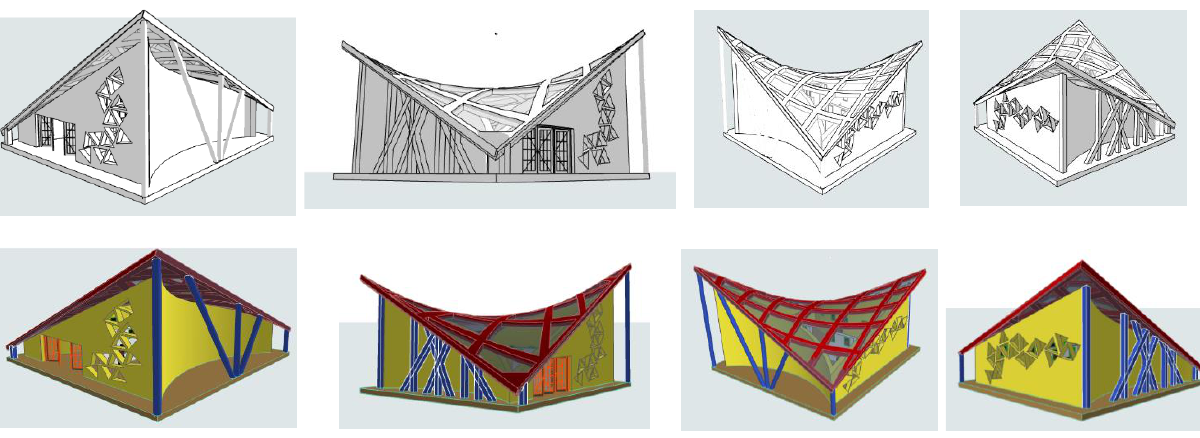
Figure 3. Uses of different textures and colours tones on the project.